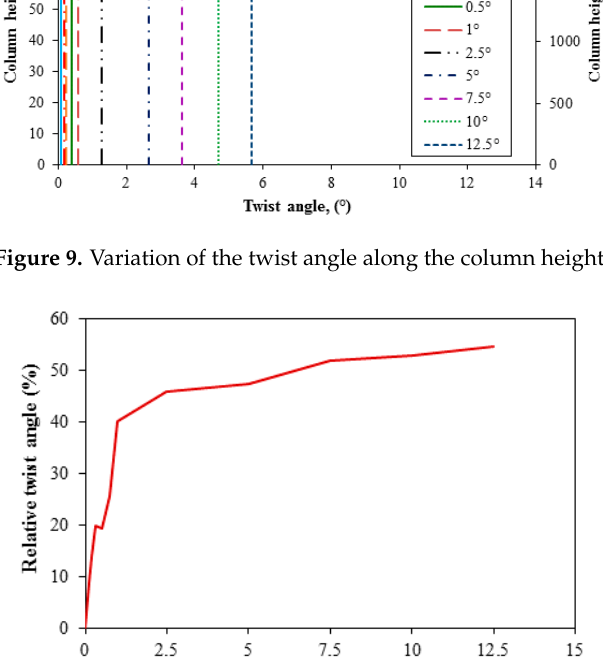
Figure 10. Relative twist angle across different twist angles.